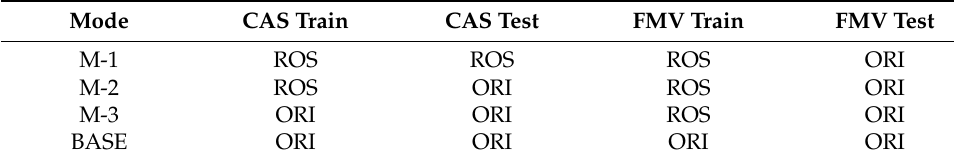
Table 2. Dataset-processing mode settings for different strategies.